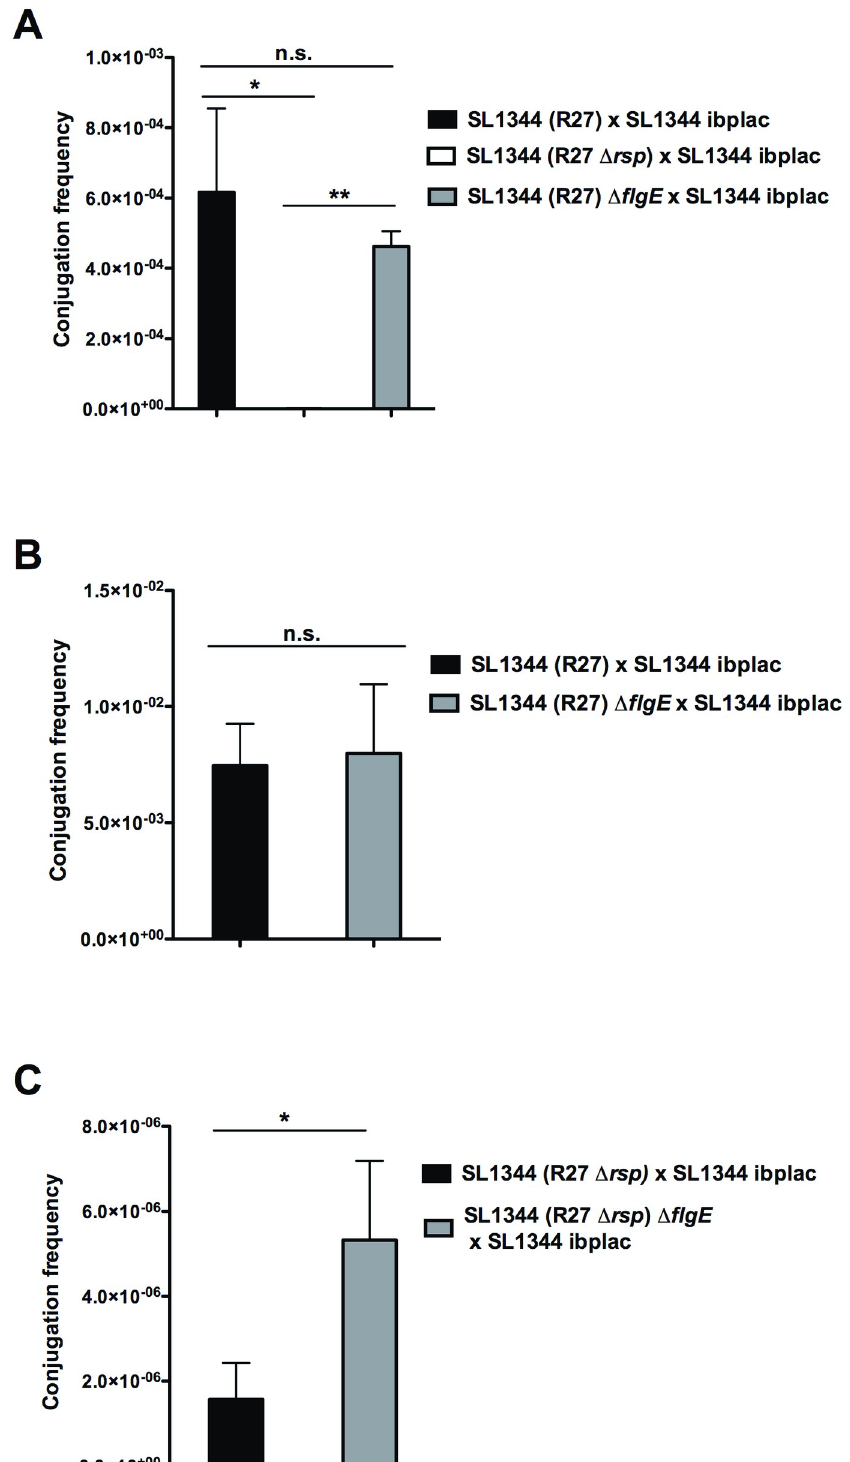
Fig 8. Conjugation frequencies of R27 and R27 Δ rsp plasmids using SL1344 and SL1344 Δ flgE as donor strains. Conjugations were performed either in liquid (A) or on nitrocellulose filters (B, C). The data shown are the means and standard deviations of three independent experiments. Statistical analysis showed significant differences ( � P - value < 0.005; �� P -value < 0.001), n.s., not significant.